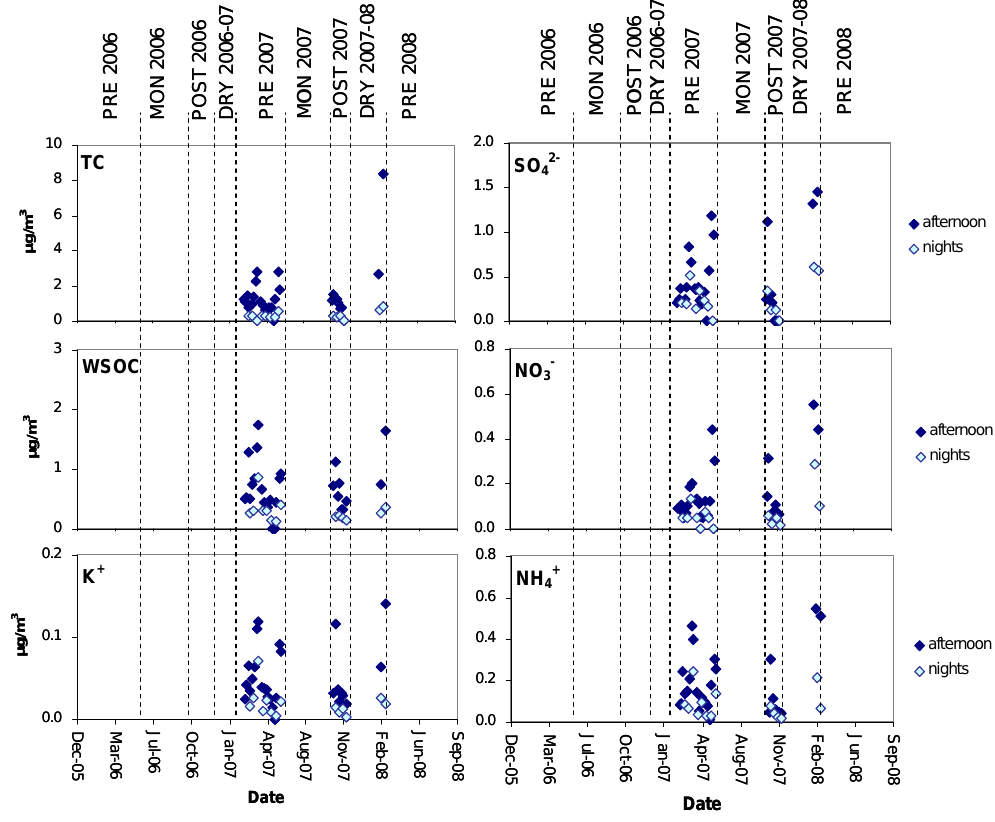
Fig. 2. Concentrations of the main ionic and carbonaceous species in PM 1